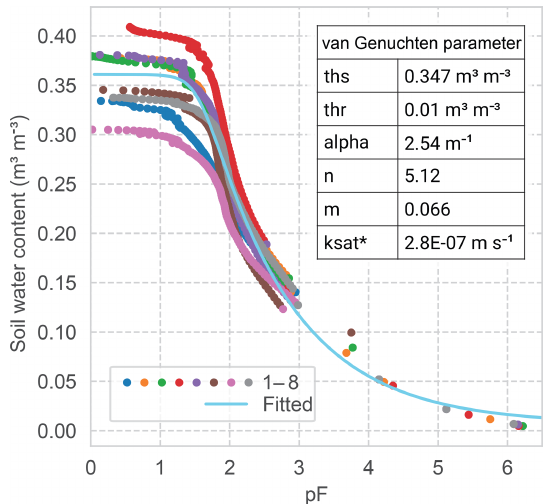
Figure 3. Soil water retention data from eight 250mL ring samples analysed in HYPROP and WP4C apparatus. Fitted van Genuchten model with free m parameter and diffusive hydraulic conductivity k ∗ sat